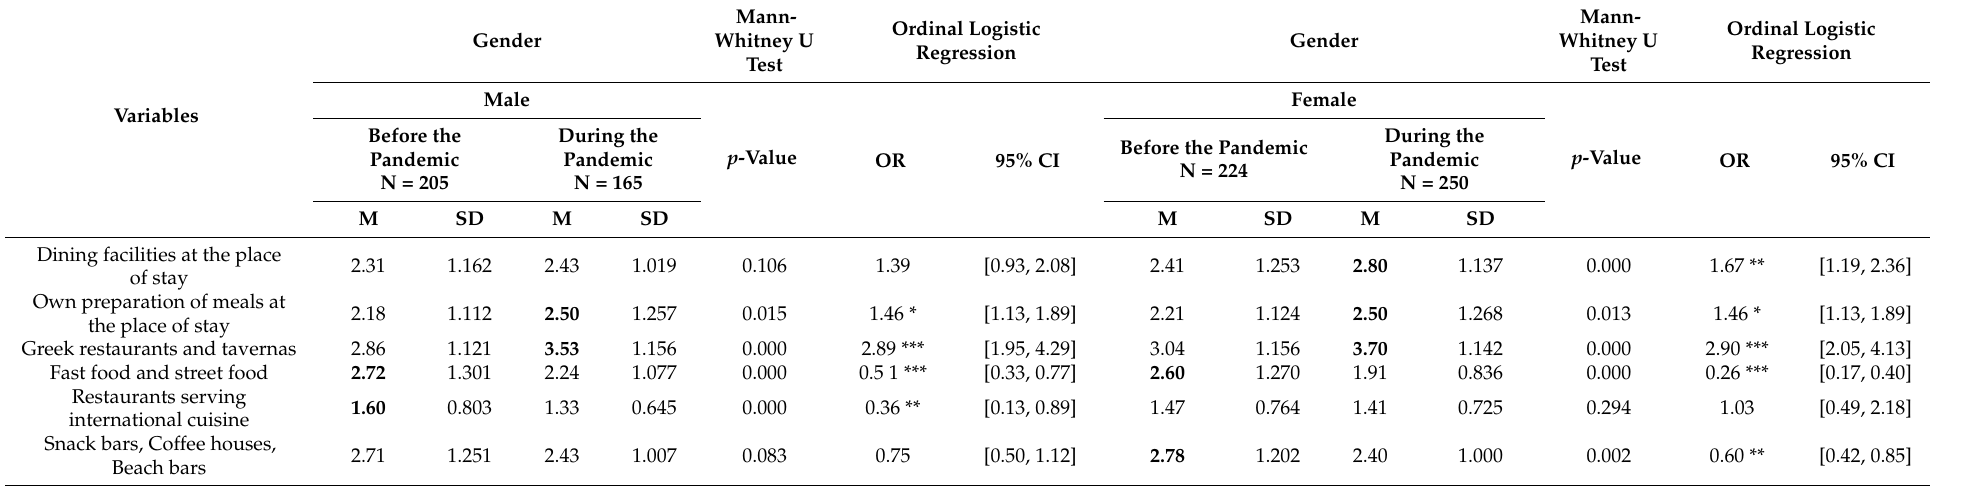
Table 8. The pandemic’s effect on dining facilities